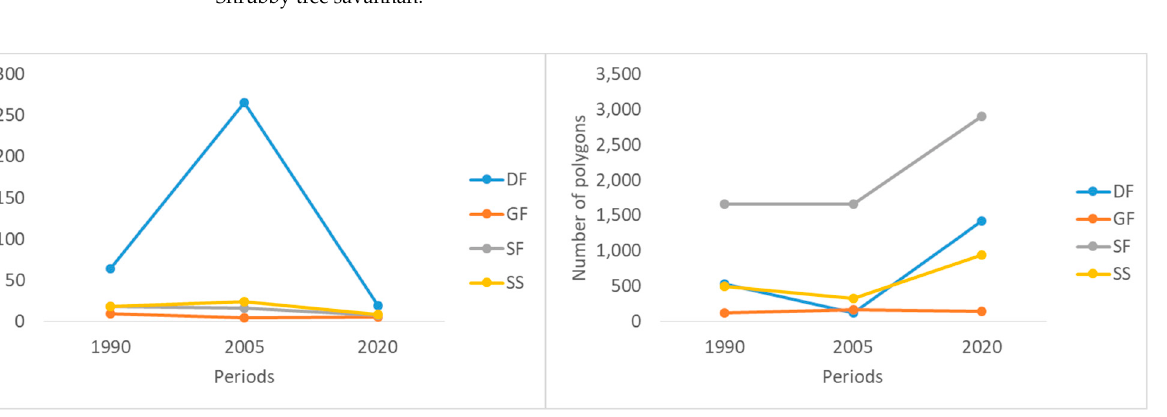
Figure 4. Evolution of the average area and the number of polygons based on the observation peri-